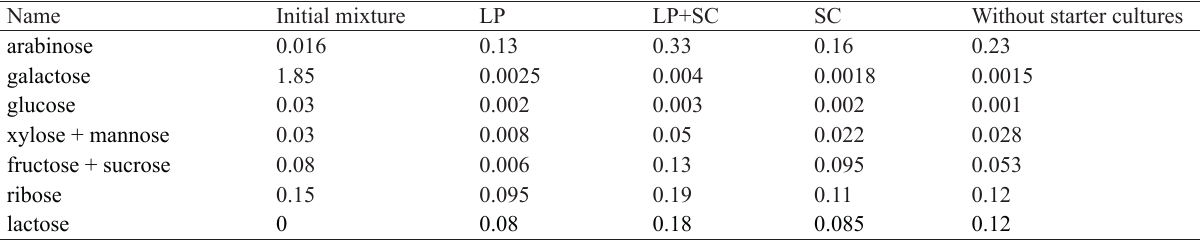
Table 4 Changes in free carbohydrate contents in the animal-based food system caused by Lactobacillus plantarum , Staphylococcus carnosus and their mixture, % (g/100 g of sample